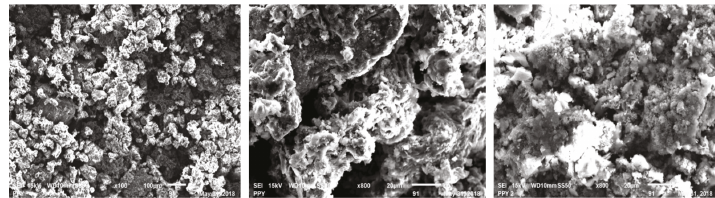
Figure 3: Microstructure of PPy samples where ammonium persulphate was used as an oxidizing agent (oxidant 0.1M, pyrrole 0.05 M, and surfactant 0.025M at 25 ° C and duration of 4h).